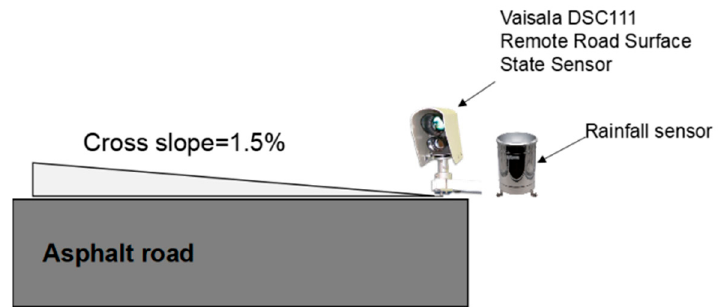
Figure 10. The schematic diagram of the validation test.